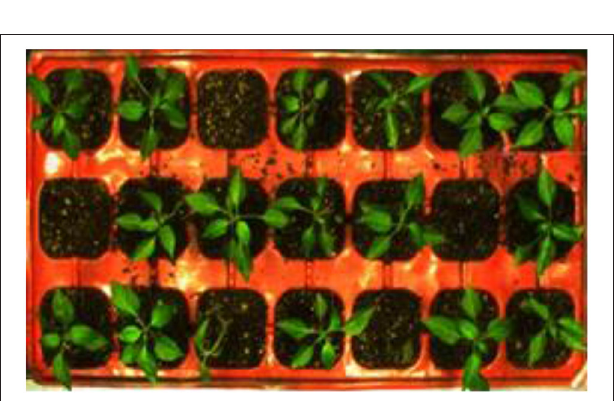
FIGURE 2 | The original tray image with potted